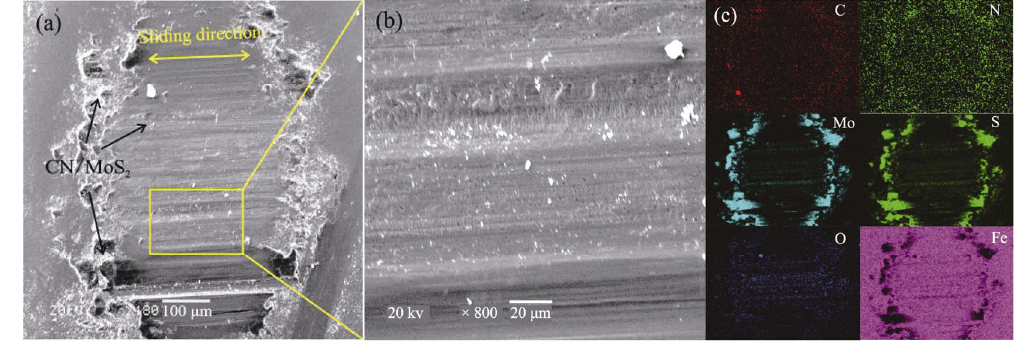
Fig. 6 (a, b) SEM images of wear surfaces, and (c) EDS mapping of the counterpart ball after sliding.